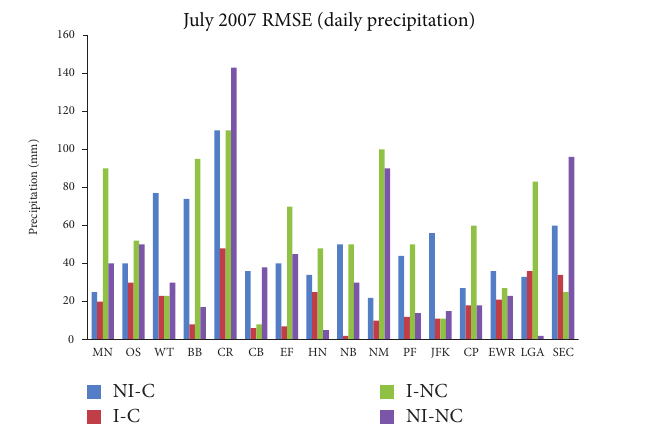
Figure 5: Accumulated daily precipitation RMSE for all monthly cases. The bar graph (b) is representative of actual RMSE values for NI-C (blue), I-C (red), I-NC (green), and NI-NC (purple) over 16 sites. The spatial plots (a) are attained via interpolation of error at the closest grid point to the model